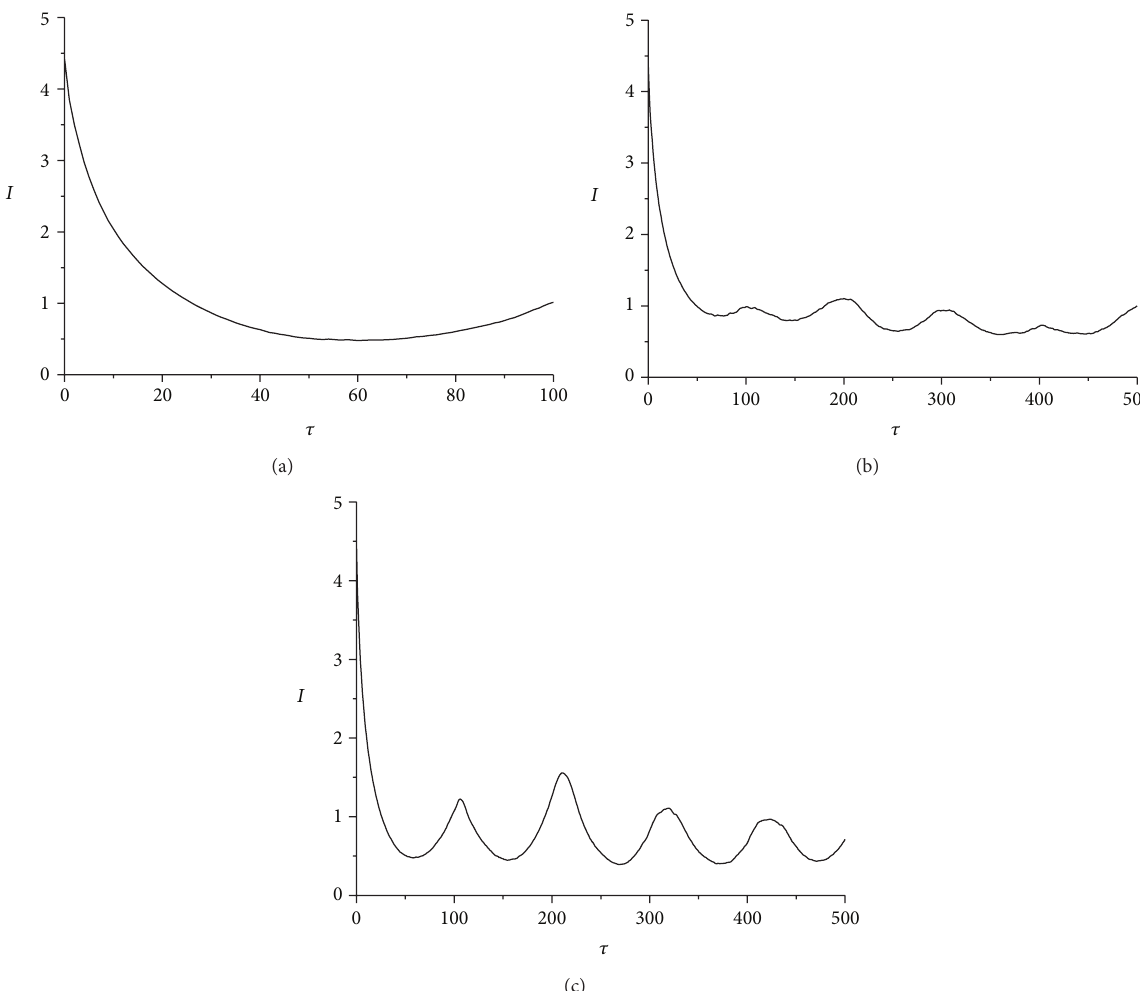
Figure 9: Average mutual information 𝐼(𝜏) versus 𝜏 time delay for spin rate 𝜔 1 (𝑡) time-series in the case of (a) wax, 𝜏 = 53 , 𝑊 = 60 , (b) gypsum, 𝜏 = 63 , 𝑊 = 358 , and (c) lead solder, 𝜏 = 58 , 𝑊 = 58 . 𝜏 is the first minimum and 𝑊 is the absolute minimum and this value is regarded as the Theiler